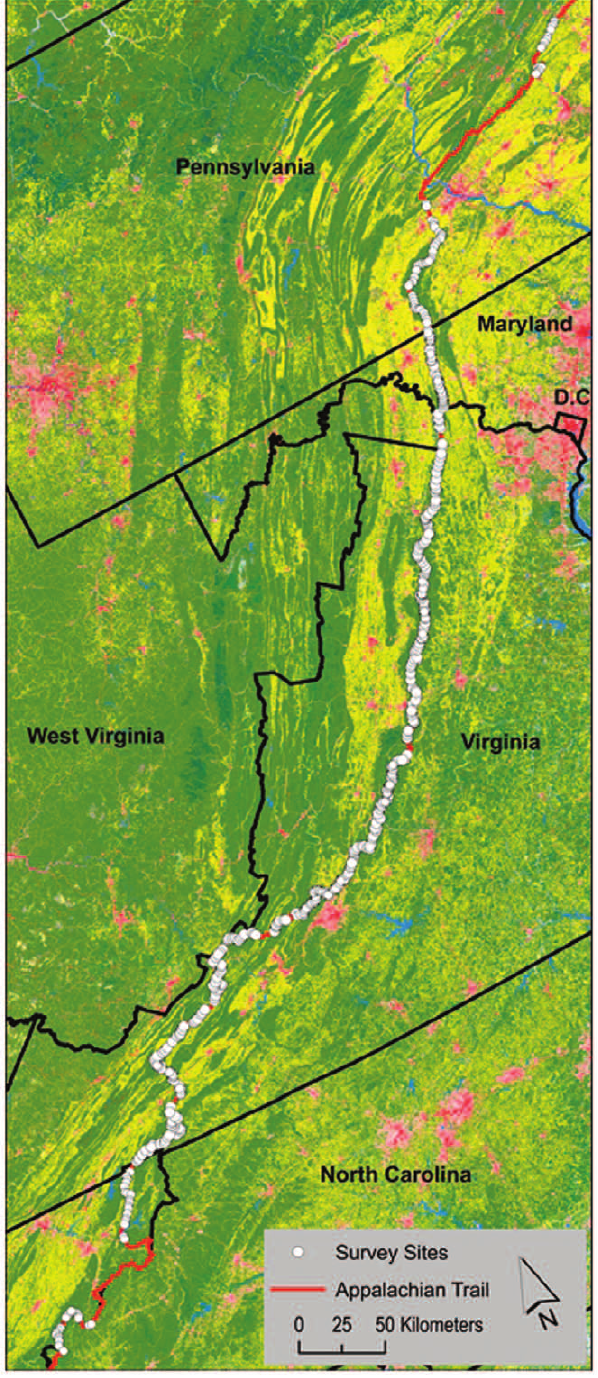
Figure 1. Map of study area and distribution of survey sites along the Appalachian Trail. The 2006 National Land Cover Data is used to indicate forest (green), agricultural (yellow), and urban (red/ gray) land use.